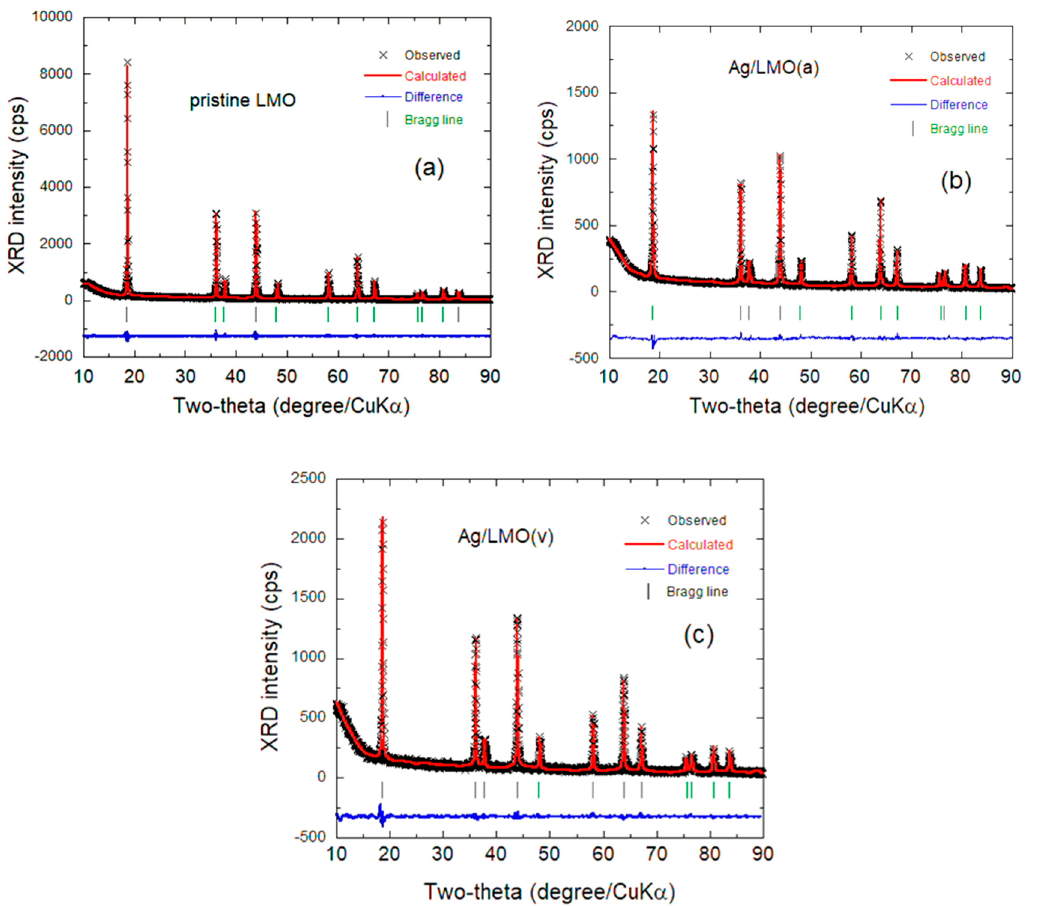
Figure 3. Rietveld refinements of XRD patterns of: as-prepared pristine LMO ( a ); Ag / LMO treated in air ( b ); and Ag / LMO calcined in vacuum ( c ).